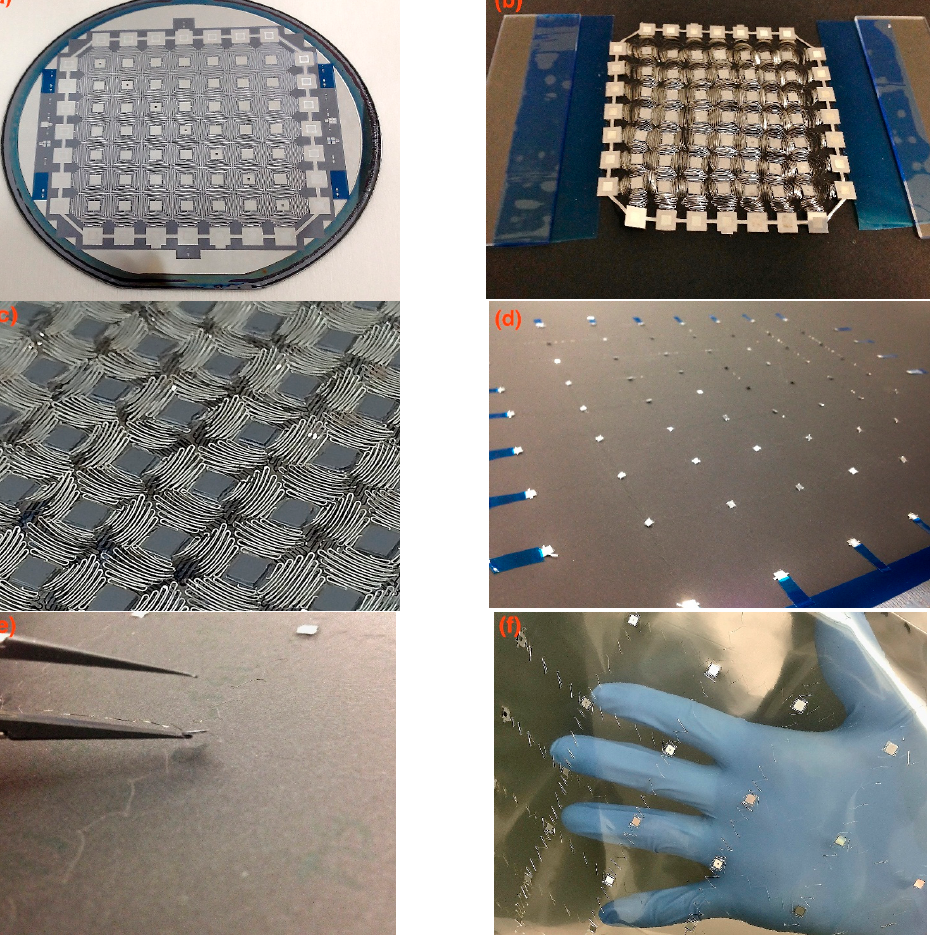
Figure 3. ( a ) Patterned pressure sensor network before releasing; ( b ) Released network before stretching; ( c ) Zoomed-in view of stretchable wires; ( d ) Stretched pressure sensor network; ( e ) Zoomed-in view of a silicon island and stretchable wires; ( f ) Stretched pressure network mounted onto a PVC soft film.